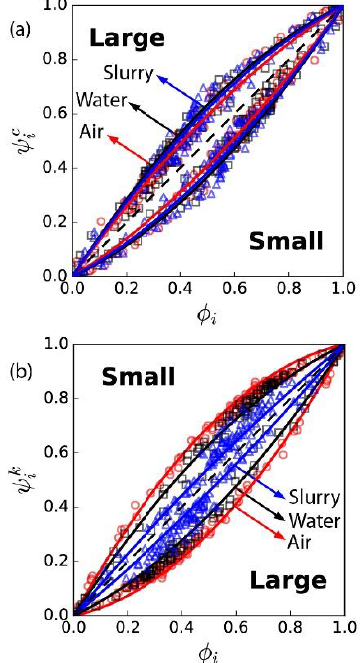
Fig. 5. (a) 𝜓 𝑖𝑐 and (b) 𝜓 𝑖𝑘 as a function of the volume concentration 𝜙 𝑖 during rapid segregation in different ambient